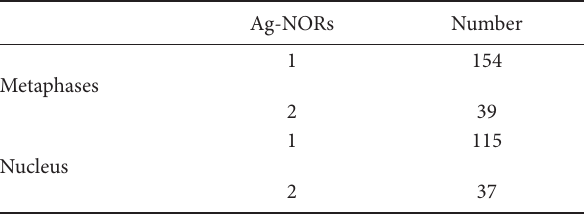
Table 1. Number of metaphases and nucleus presenting one or two Ag-NORs for the hybrid “cachandiá”.